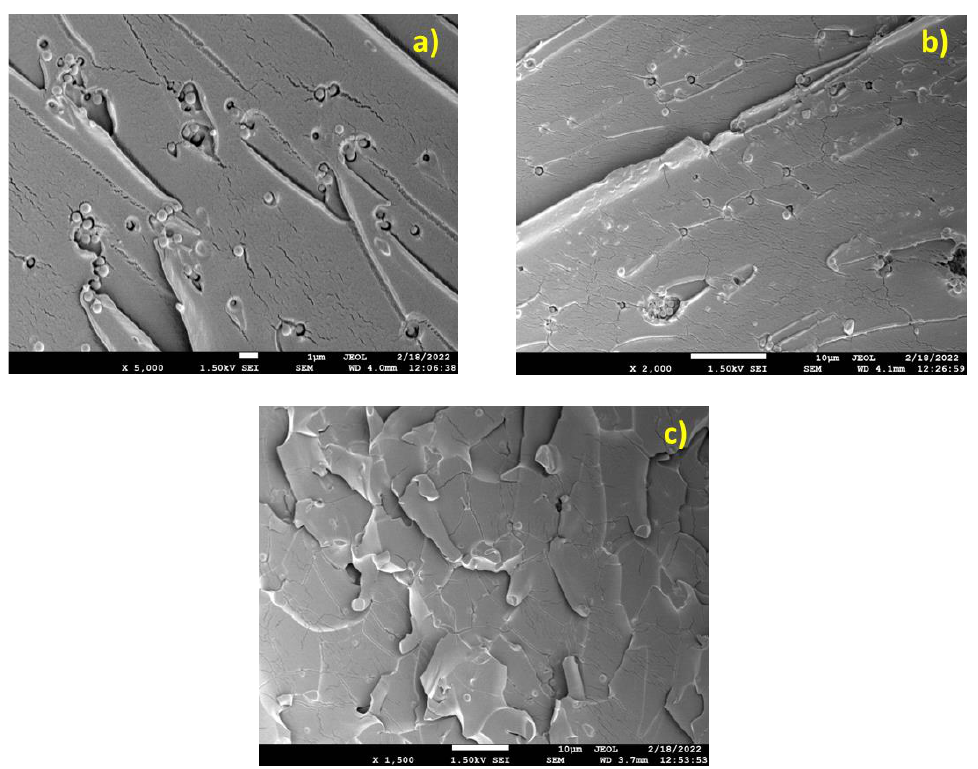
Figure 3. SEM micrographs of Resin/SiO 2 micro-composites, ( a ) Resin/0.5, ( b ) Resin/1.0, ( c ) Resin/1.5.